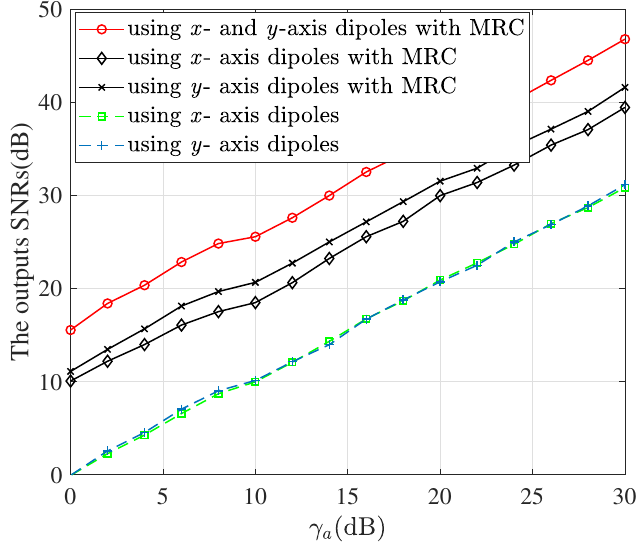
Figure 6. The output SNRs versus the γ a , where N = 8 and M =